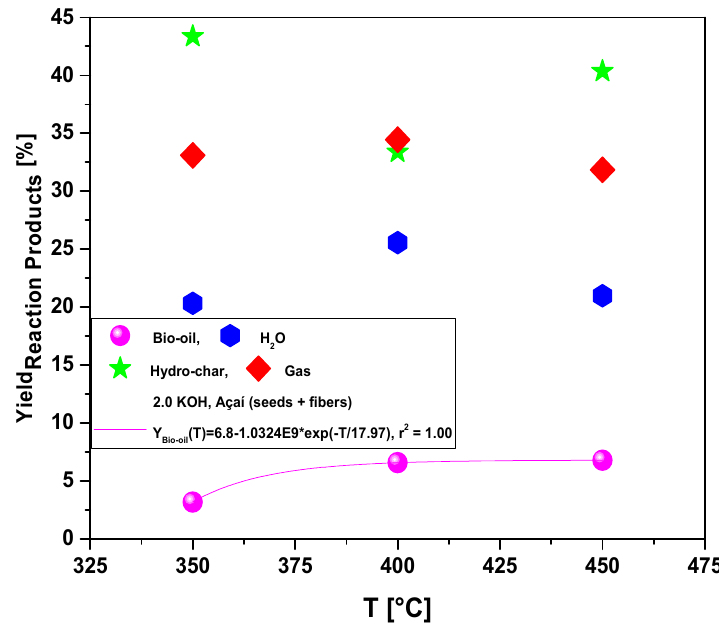
Figure 4. Yield of reaction products (bio-oil, H2O, hydro-char, gas) by pyrolysis of Açaí seeds, activated with 2.0 M KOH solution, at 350, 400, and 450 °C, 1.0 atmosphere, in laboratory scale.